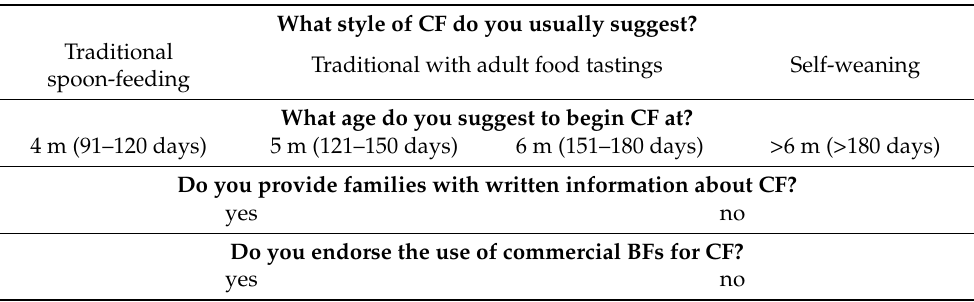
Table 1. Questionnaire sent to Italian primary care paediatricians regarding their habits about CF counselling to families.